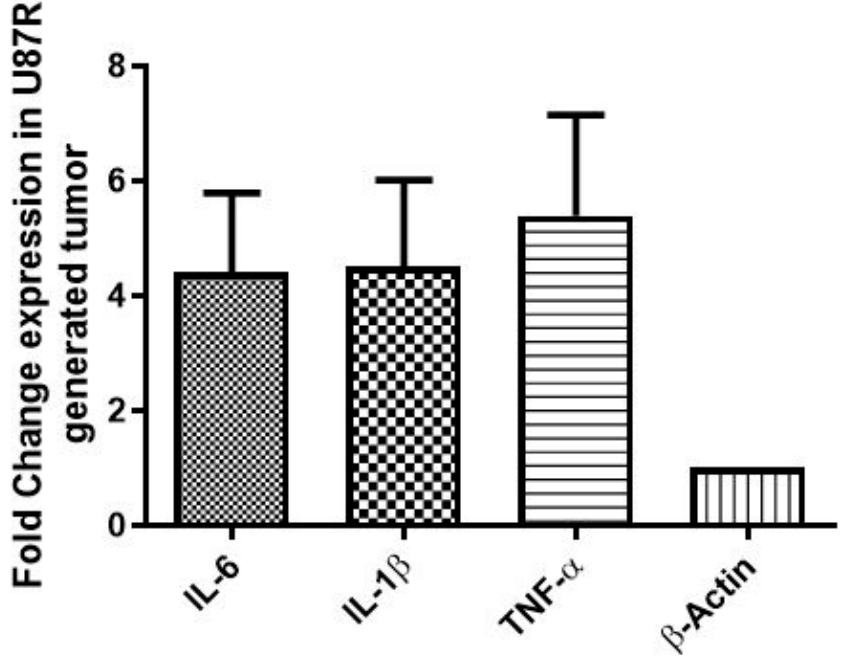
Figure 18. Fold change in gene expression of IL-6, IL-1 β , and TNF- α (inflammatory markers) in XM-S and XM-R mice in an in vivo analysis. Each bar shows mean ± SD values for each gene. Experiments were conducted in triplicates. The results are normalized to β -actin, a housekeeping gene, expressed as a change from their respective controls.